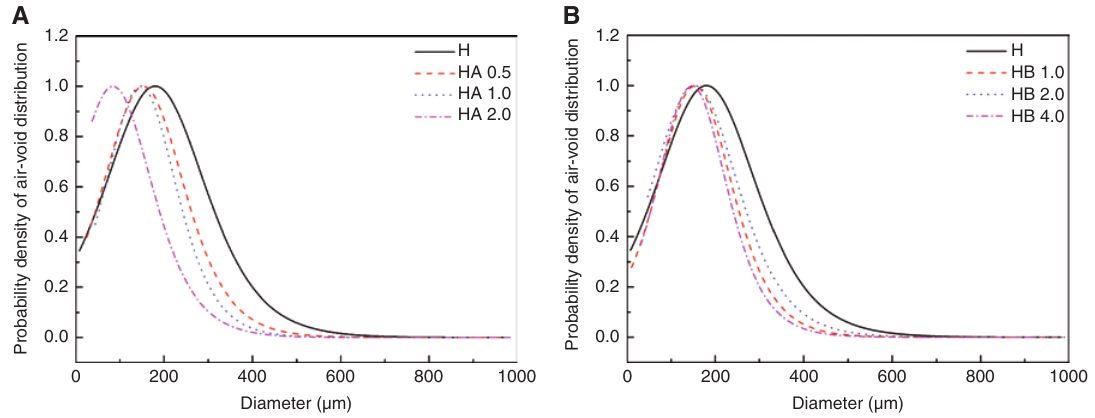
(left) and Ca(NO ) (right) in air-entraining concrete. [*The capital letters are representing 2 3 2 , B-Ca(NO ) , while the numbers are representing the dosage of 2 3 2